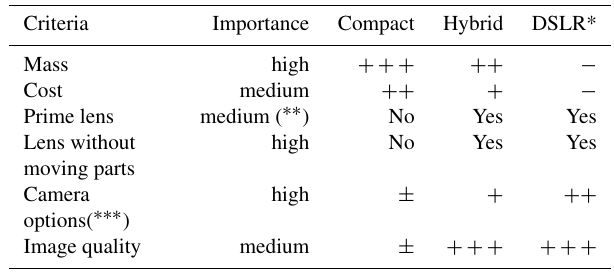
off the autofocus and the image stabiliser, both of which make auto-calibration